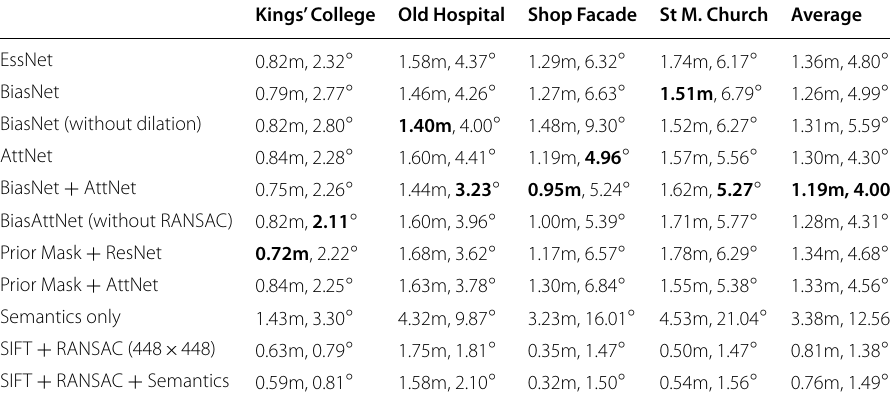
We compare the pipeline that has individual modules removed or replaced. The best results are highlighted in bold except for methods marked with a